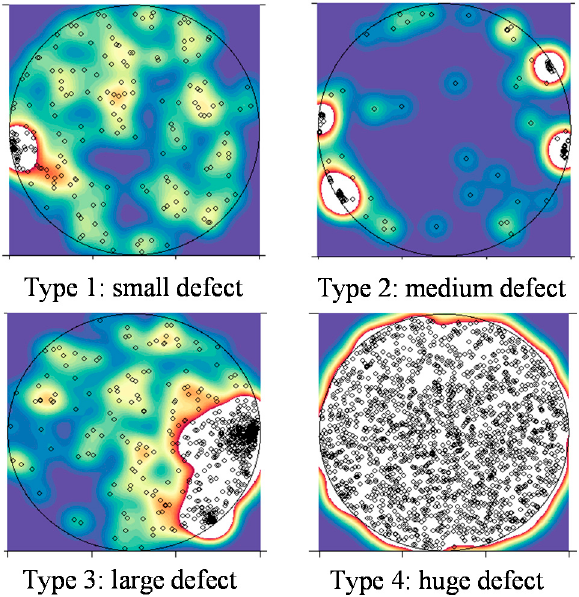
Figure 10. Levels of the defects in the etching process. Table 1. Defect datasets.